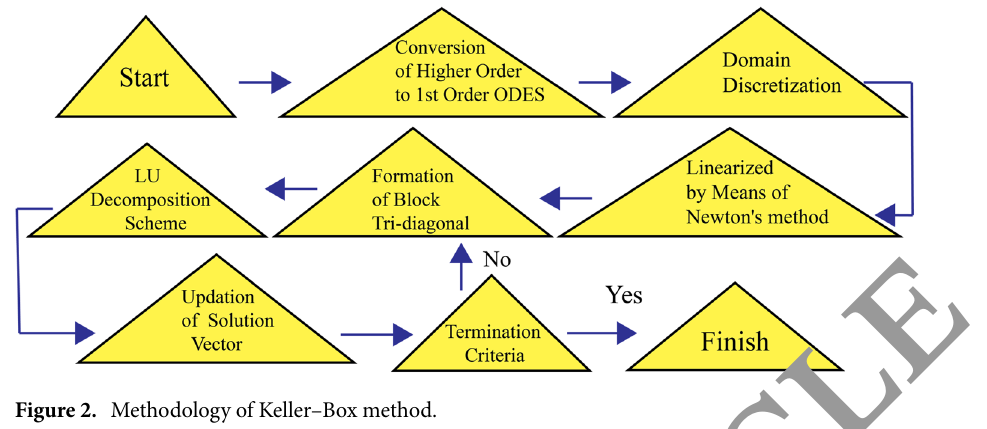
Figure 2. Methodology of Keller–Box